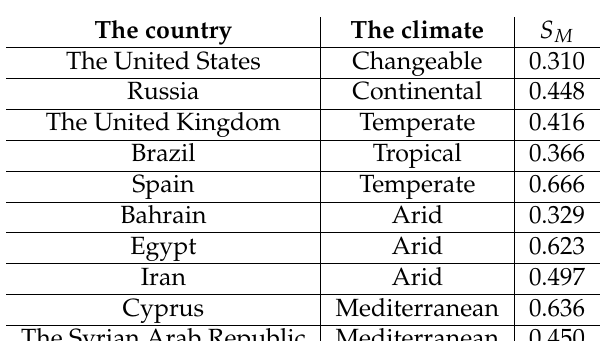
Table 2. 2 The values of the steady state population of SARS-CoV-2 in the United States, Russia, the United Kingdom, Brazil, Spain, Bahrain, Egypt, Iran, Cyprus and the Syrian Arab Republic and the climate type of each